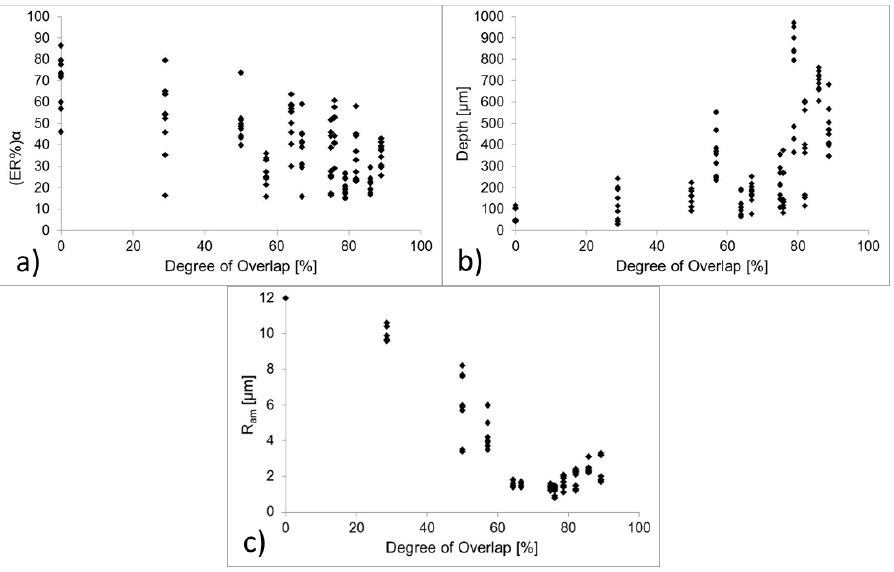
Figure 7. Tendency of (ER%) α ( a ) of Average Depth ( b ) and Roughness Ram ( c ) with the degree of overlap.